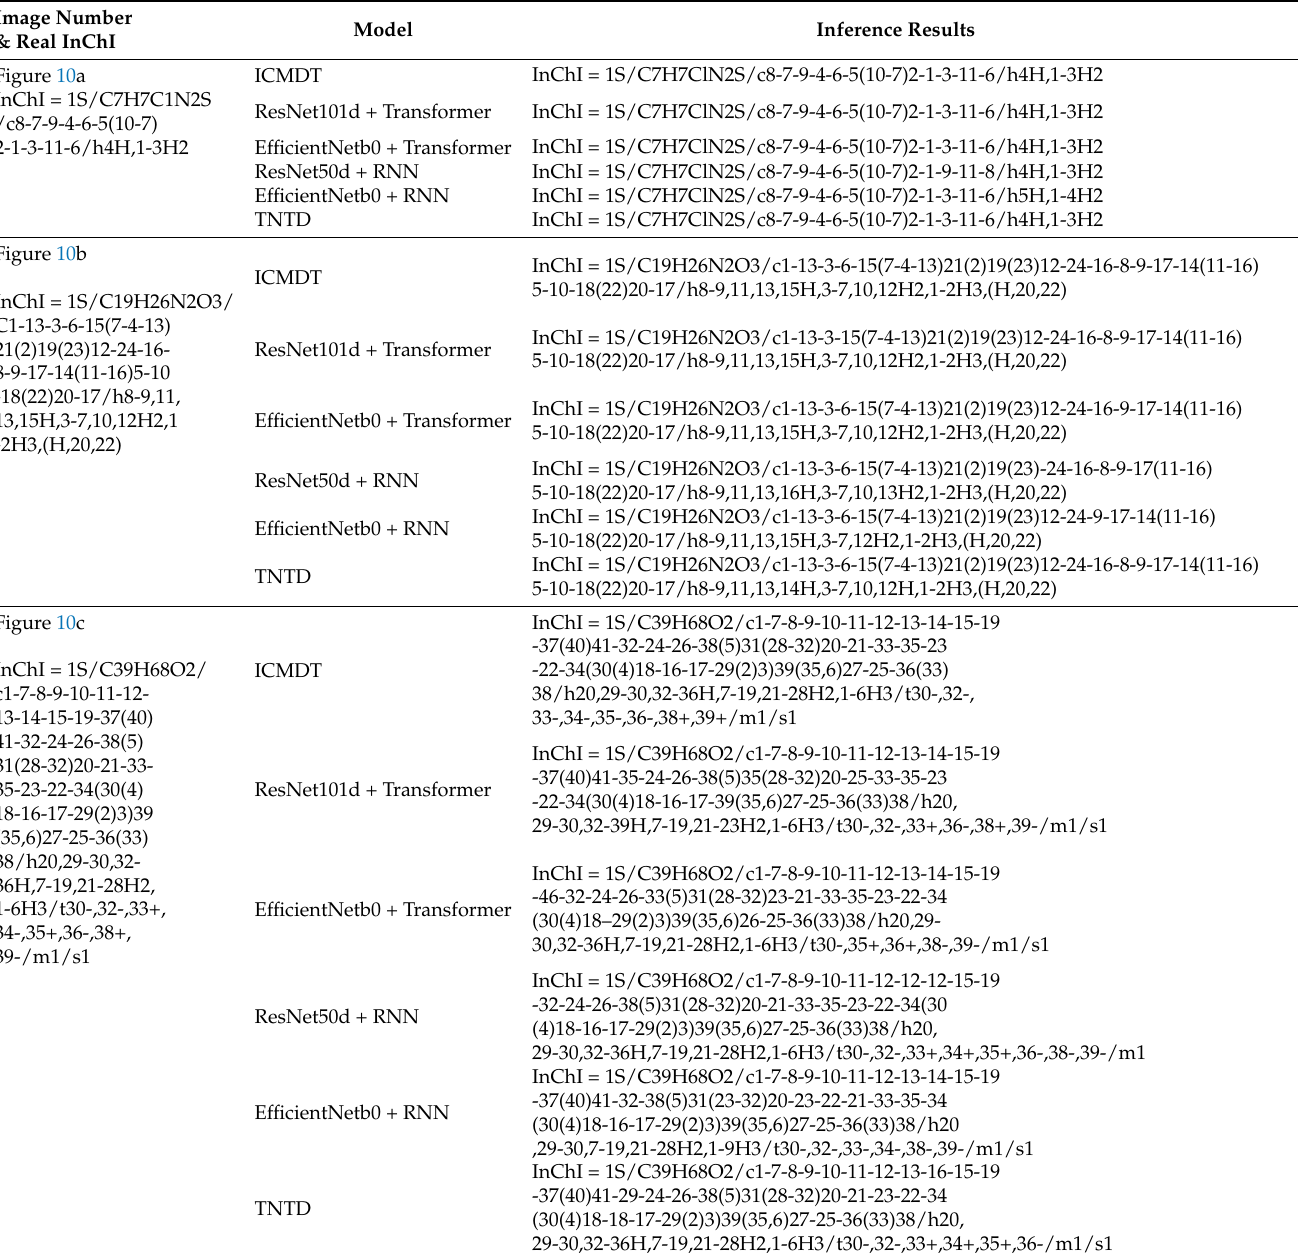
Table 6. Results of ICMDT and other comparative models for the inference of three types of chemical